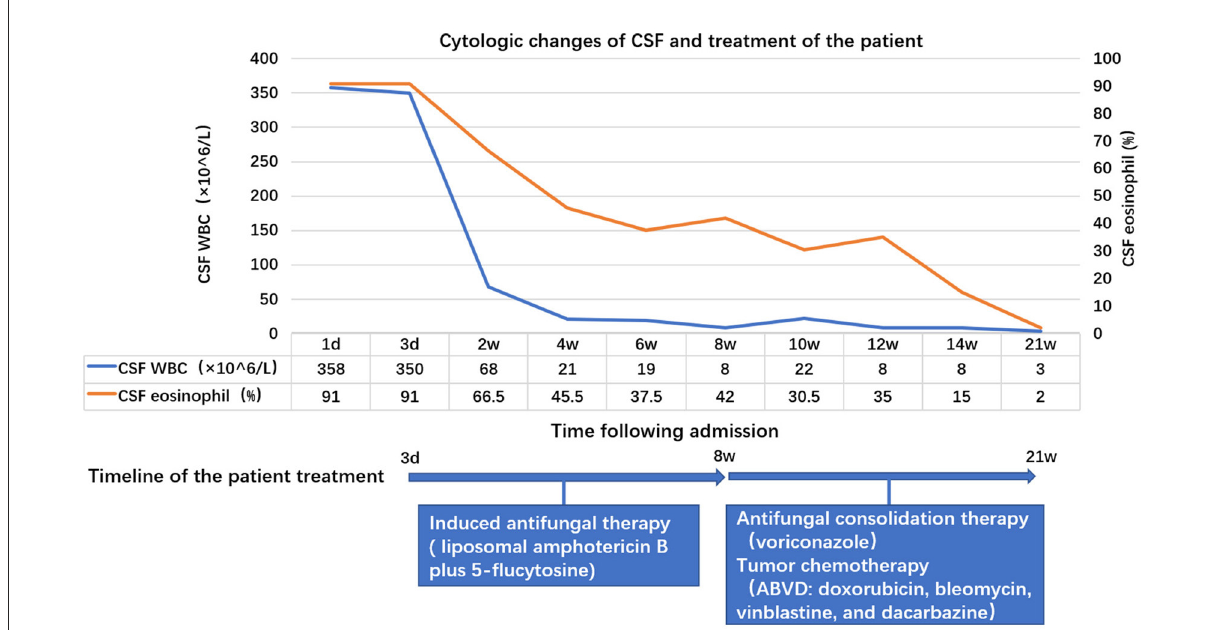
FIGURE2 Changes in the leucocyte count and proportion of eosinophils in the cerebrospinal fluid (CSF) with treatment. On the first day of admission, the leukocyte count was 358 × 10 6 /L (91% eosinophils), which decreased to 8 × 10 6 /L (42% eosinophils) after about 8 weeks of antifungal induction therapy, and to 3 × 10 6 /L (2% eosinophils) after 13 weeks of antifungal consolidation therapy combined with tumor chemotherapy.